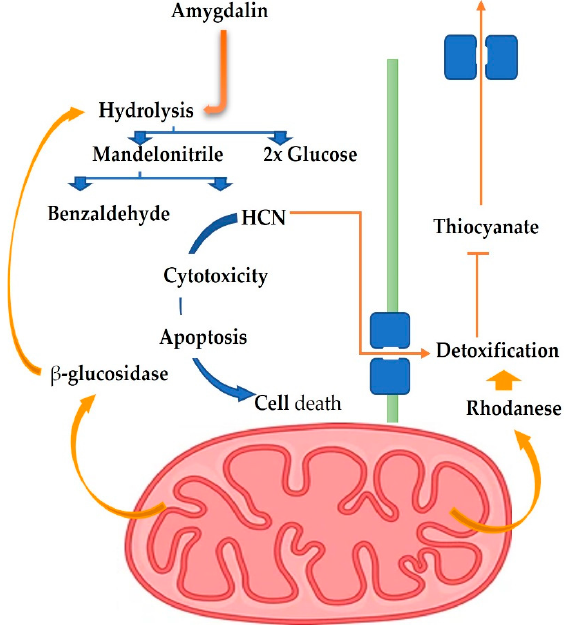
Figure 2. Controlling AMD in cancer and normal cells: the function of RHD and BGD [27].